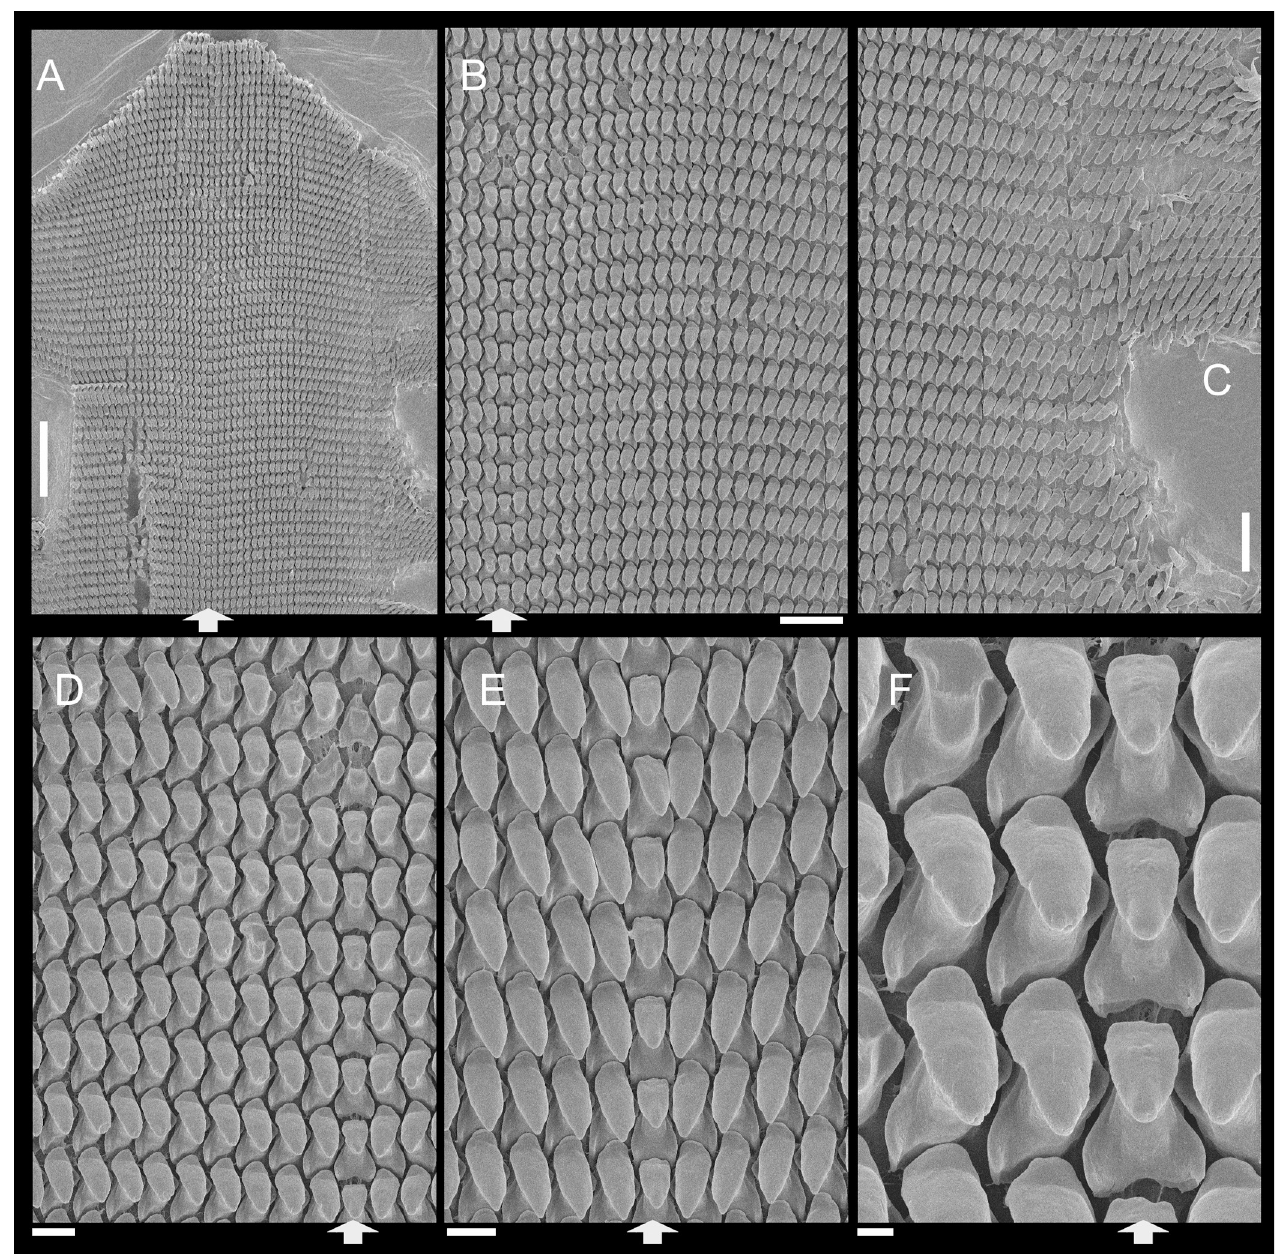
Fig 22. Catracca uhlei , radula in SEM, holotype MZSP 151893. (A) wide view, scale = 300 μ m; (B) detail of central region, scale = 100 μ m; (C) detail of lateral region, scale = 100 μ m; (D) detail of central region, scale = 50 μ m; (E) same, higher magnification, scale = 30 μ m; (F) same, higher magnification, scale = 10 μ m. White arrows indicating rachidian column. 20I), running from suture to suture, interspaces similar to each cord’s width, ~10 per mm; transition to teleoconch distinct, slightly prosocline (Fig 20E and 20H). Teleoconch of ~2 whorls, profile slightly convex; sculpture similar to that of protoconch last whorl, as axial, uni- form, complete cords and growth lines, slightly more irregular on last whorl (Fig 20A, 20C, 20D and 20G). Suture well-marked, slightly channeled (Fig 20B, 20C, 20E and 20G). Aperture